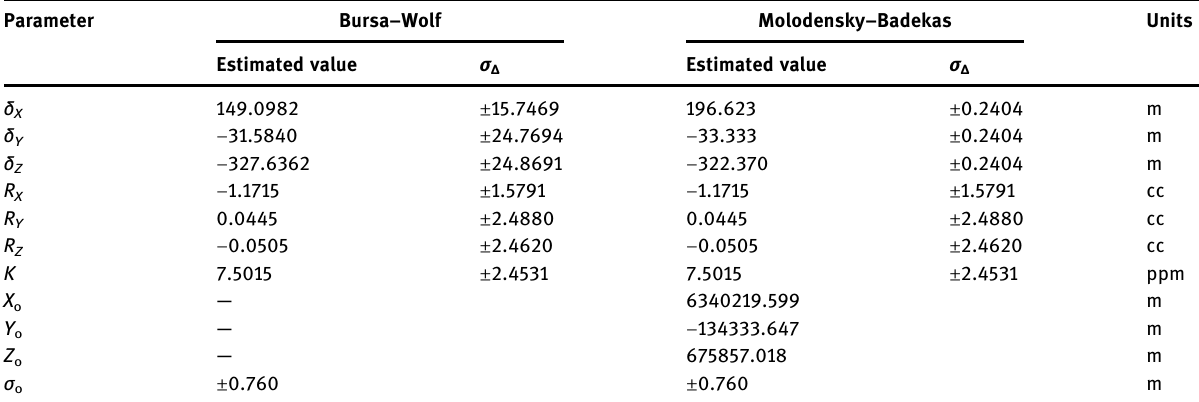
Table 1: 7 - parameters transformation Parameter